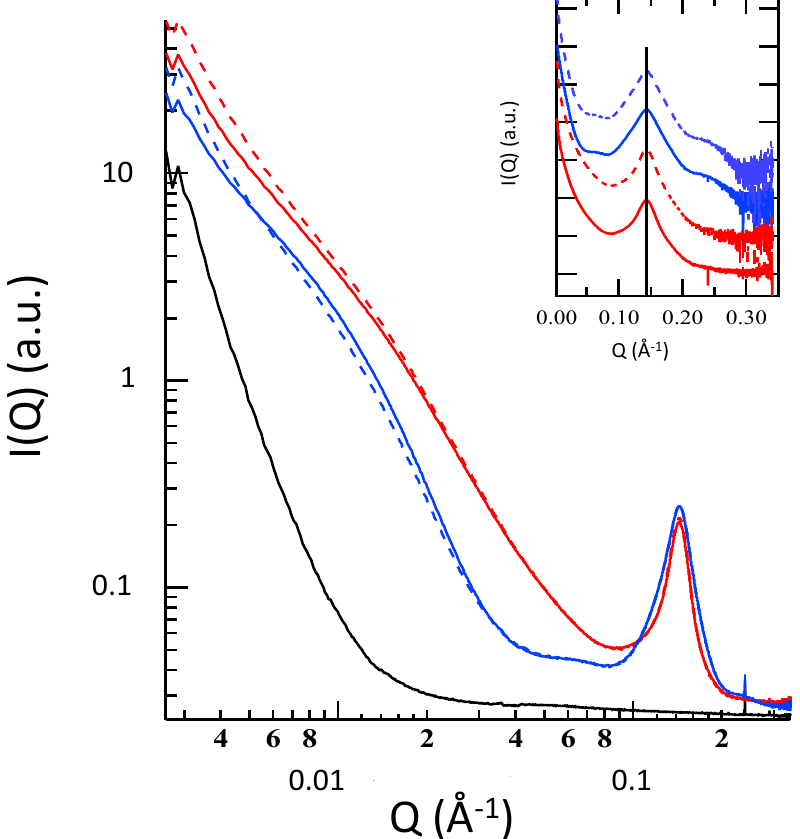
Figure 2. Small-angle X-ray scattering (SAXS) profiles of e-NLC1 (full blue line), e-NLC2 (full red line), NLC-EA1 (dotted blue line), NLC-EA2 (dotted red line). The signal of sole water is indicated with a black line. The inset shows the SAXS profiles after the subtraction of the water contribution. Here, the curves are scaled for clarity. The vertical black line indicates the constant position of the Bragg peaks.